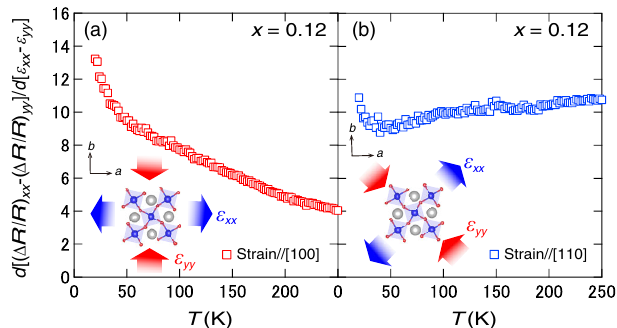
FIG. 10. Temperature dependence of nematic susceptibility in Sr 2 Ir 0 Rh 0 O 4 . (a) Strain applied along the [100] direction. . 88 . 12 (b) Strain applied along the [110] direction. The insets illustrate the directions of applied strain and the IrO 6